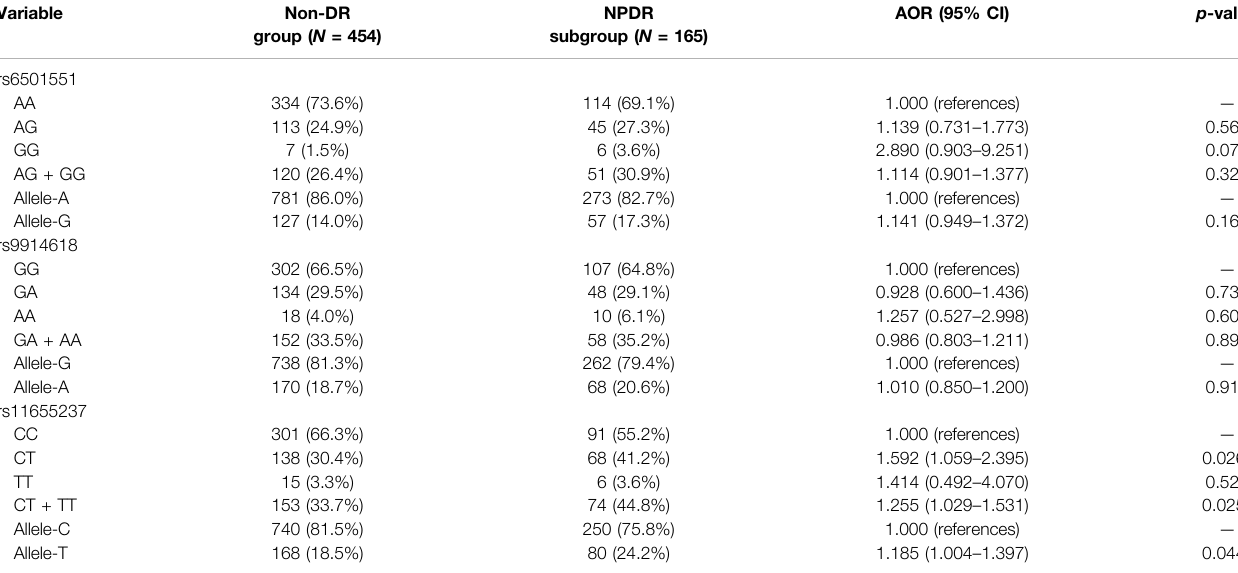
TABLE 3 | Adjusted odds ratio and 95% con fi dence intervals of non-proliferative diabetic retinopathy associated with LINC00673 genotypic frequencies.